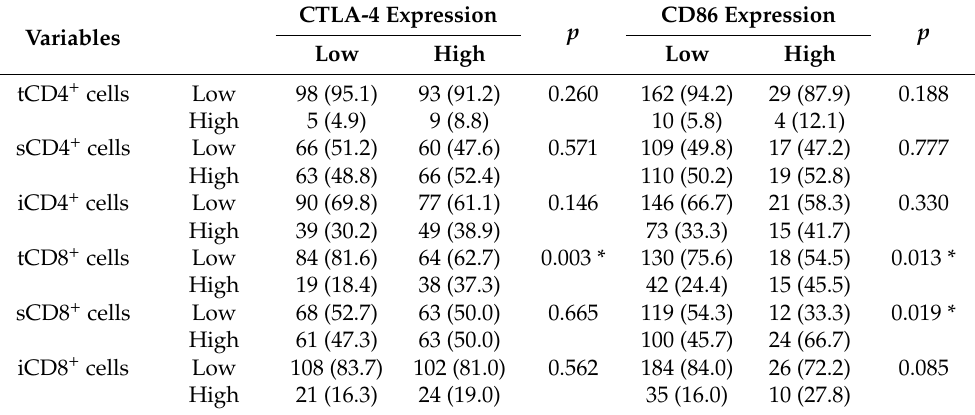
Table 3. Correlation between CTLA-4/CD86 expression and CD4 + /CD8 +